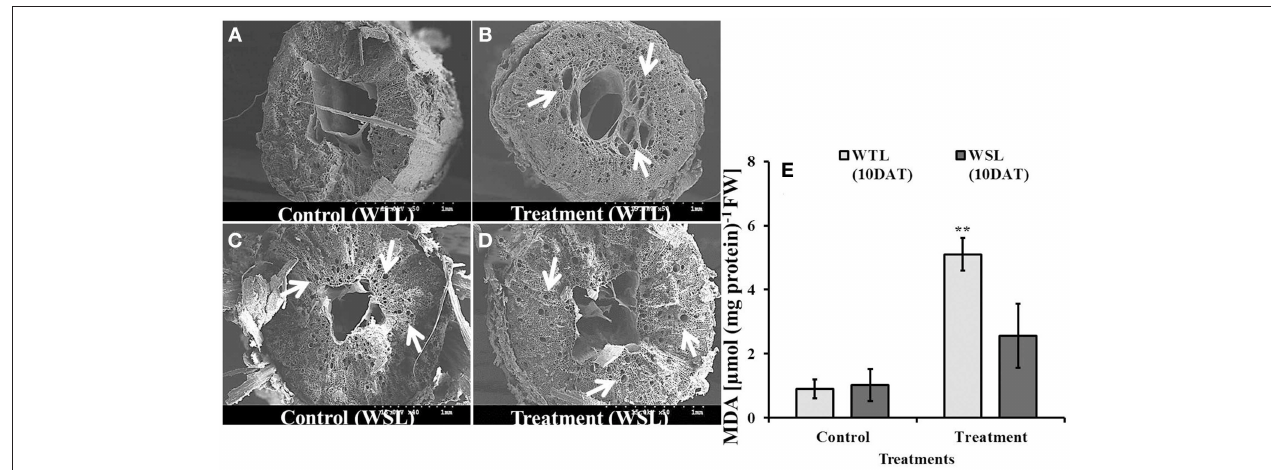
FIGURE 7 | The images of root section (A–D) and MDA (E) in root after 10 days waterlogging treatments. In the figure, WTL indicates the waterlogging tolerant line (PI408105A) and WSL indicates the waterlogging susceptible line (S99-2281). The arrows in (B–D) indicate aerenchyma cells in the root. (E) Shows lipid peroxidation (MDA) in the root and star marks indicate a significantly difference between control and treatment at P < 0.05 or P < 0.01. Data is the average ± standard error ( n = 3